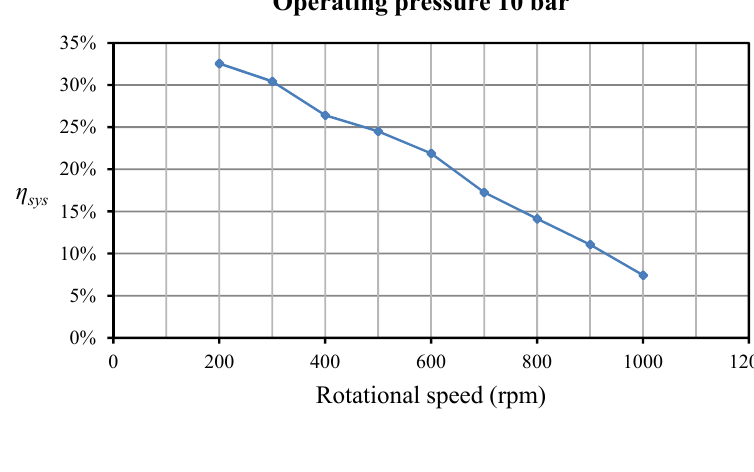
Figure 15. The system efficiency under the constant pressure operation.